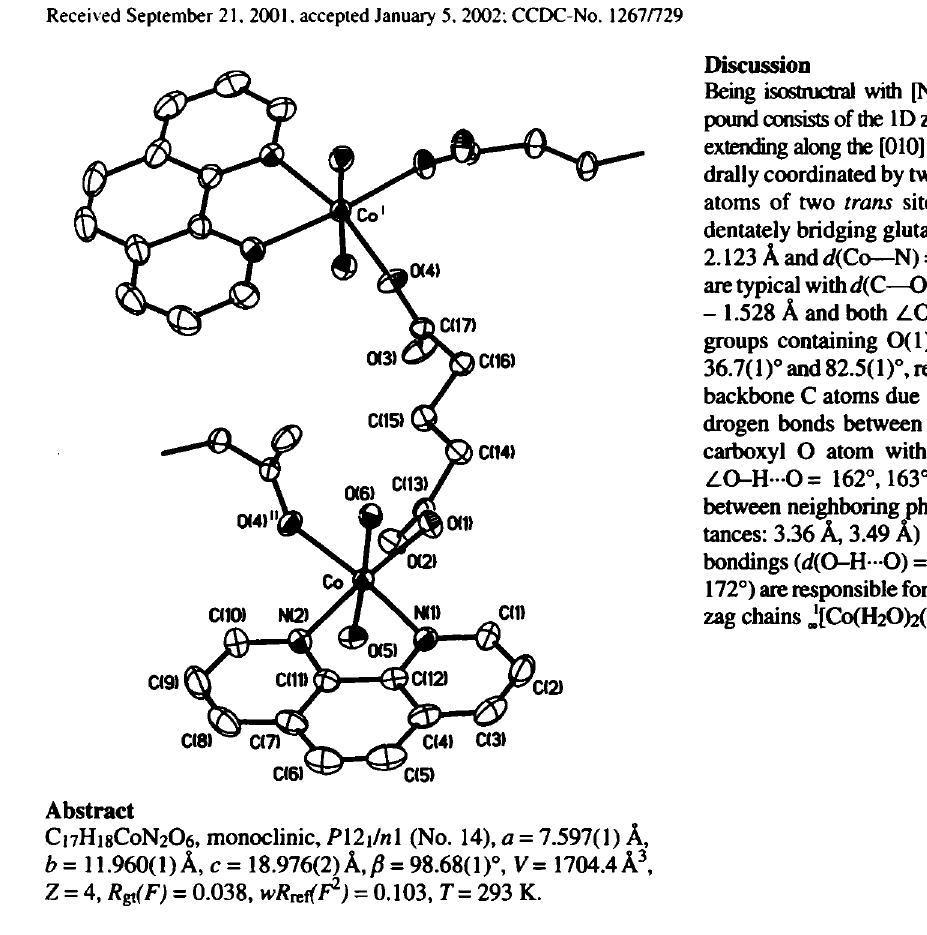
Table 1. Data collection and handling.